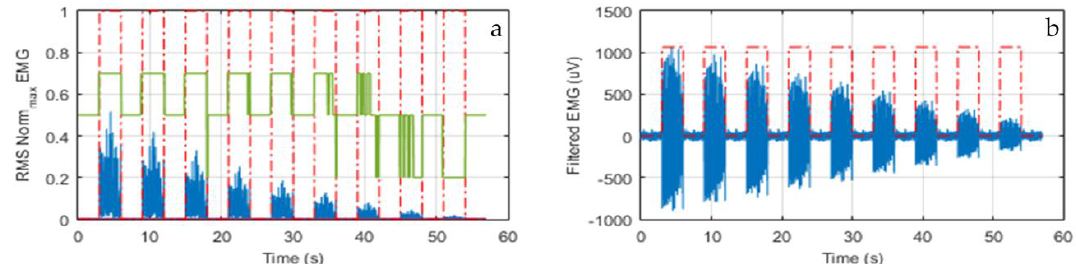
Figure 5. ( a ) The RMS signal (blue) and factor j (green); ( b ) An example of the EMG signal in the same tw